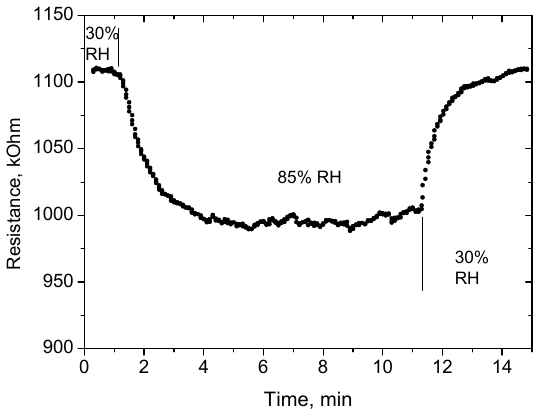
Figure 12. Results of preliminary tests of response and recovery time after change in humidity 30–85–30% RH. Sensor temperature is 450 °C.